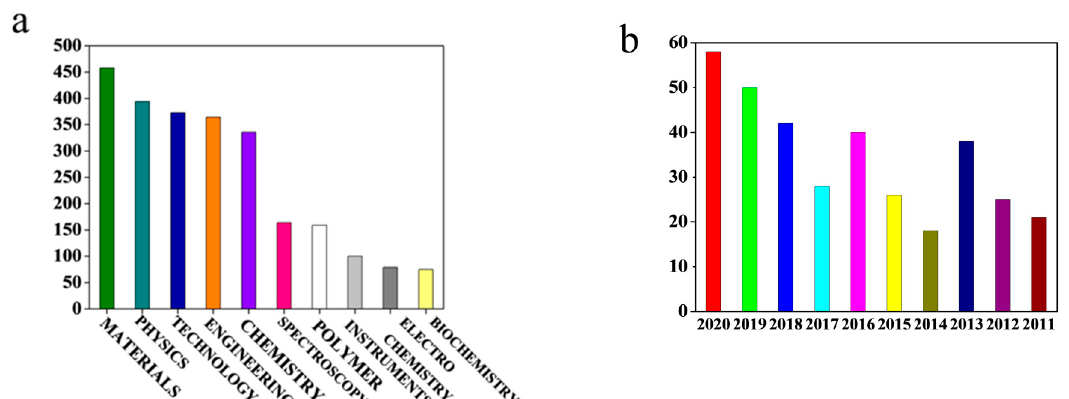
Figure 1. ( a ) Quantitative statistics of related articles on transparent as-spun nanofibers literature in various academic fields. ( b ) Statistics on the number of articles on electrospun transparent fiber membranes published each year in the last 20 years.